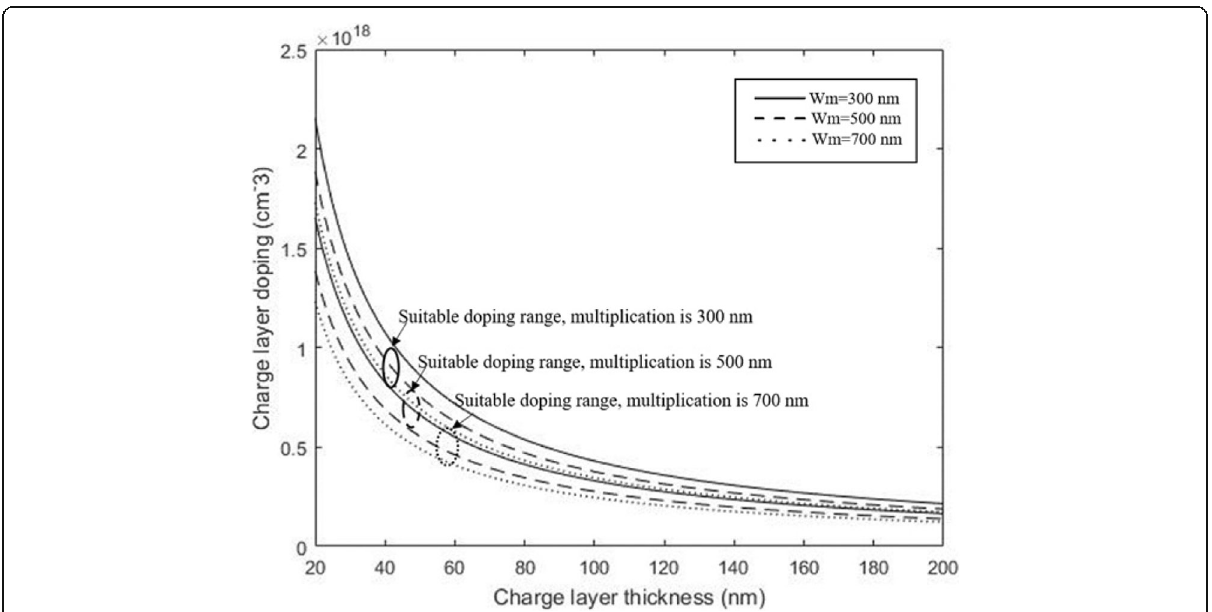
Fig. 3 The optimal doping level and thickness of charge layer for different multiplication layer. Solid line: w m = 300 nm. Dashed line: w m = 500 nm. Dot line: w m = 700 nm. Presents the calculated values of charge layer (doping level and thickness) by the formula while the field of absorption layer is suitable. The thicknesses of the multiplication layer are 300, 500, and 700 nm. When the thickness of the multiplication layer is certain, we can use the formula to find the optimal doping level and thickness of charge layer